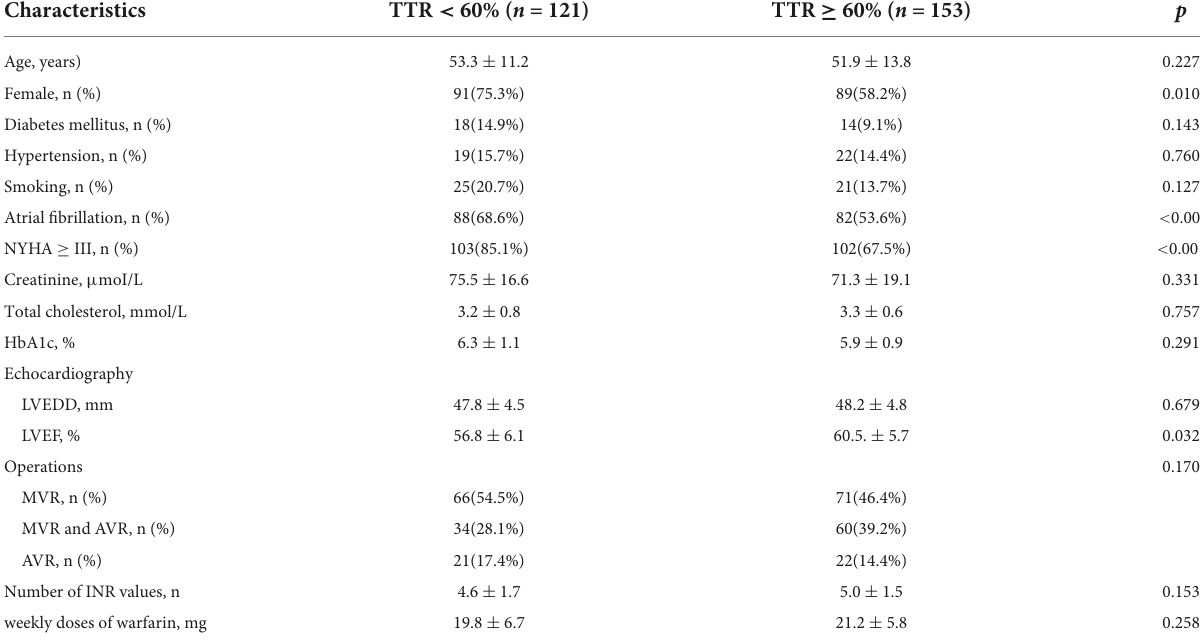
TABLE 3 Univariate analyses of preoperative variables associated with TTR < 60%.